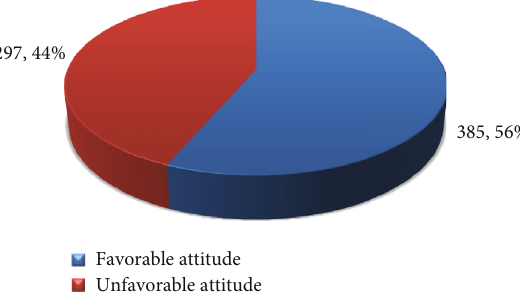
Figure 2: Client ’ s attitude towards immunization service in Wadla district, North Wollo, Amhara regional state, northeast Ethiopia,